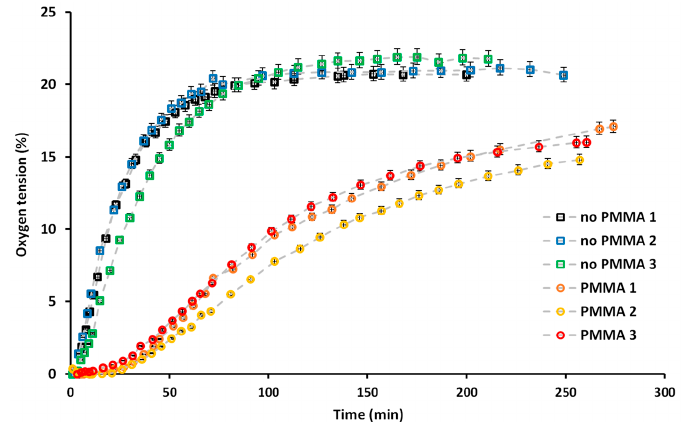
Figure 2. Characterization of the oxygen diffusion in the device over time for devices containing a PMMA sheet (circle symbols) or only PDMS (square symbols), for three independent devices for each case on three different days. Data are presented as the oxygen tension as a function of time, this being assessed by monitoring the decrease in the fluorescence intensity of the tris(2,2 (cid:48) -bipyridyl)dichlororuthenium(II) hexahydrate (Ru(BPY) 3 ) oxygen-sensitive probe added in aqueous solution in the device. Data were acquired over a period of more than 4 h, as detailed in the experimental section and analyzed as explained in supplementary material